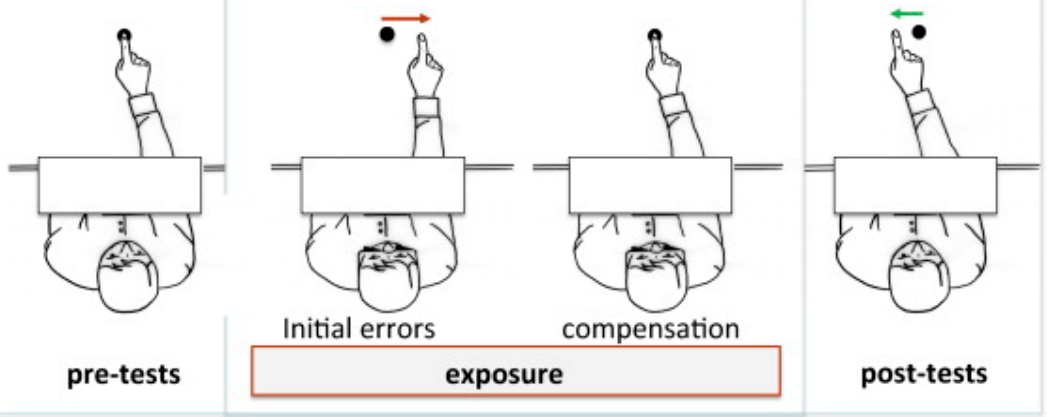
Figure 8. Pre-test ( left ), exposure ( middle ) and aftereffect ( right ). Adapted from Rode et al. [28]. During the pre-test phase, no deviation is observed (left panel). During the exposure phase, the subject wears prismatic glasses that deviate the vision by 10 degrees to the right. When the subject points at the target, the motion is shifted to the side of the optical deviation and towards the virtual target (middle left panel). The pointing deviation is gradually corrected and the deviation is completely compensated after a sufficient number of trials (middle right). After removal of the prismatic glasses, the compensation remains while the prismatic deviation is no longer present, producing a shift of motion in the opposite direction to the optical deviation, called after-effects (right panel).